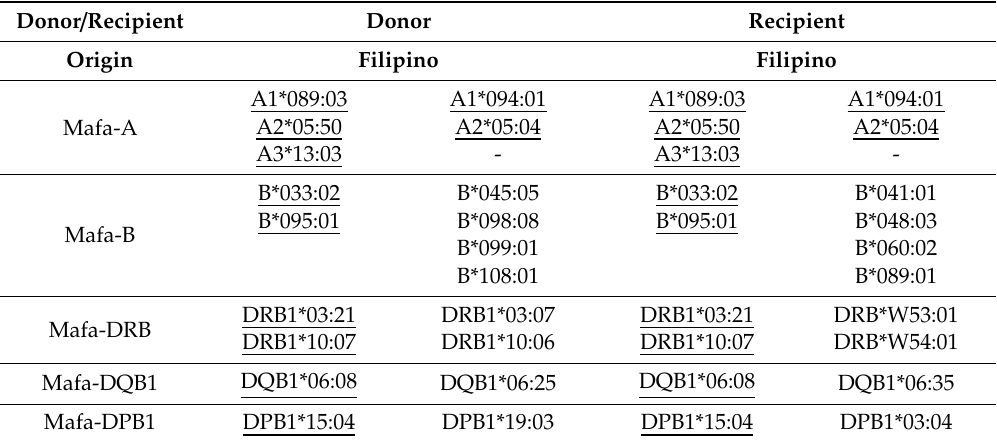
Table 2. Genotyping data of cynomolgus macaque MHC (Mafa) genes in case 2.